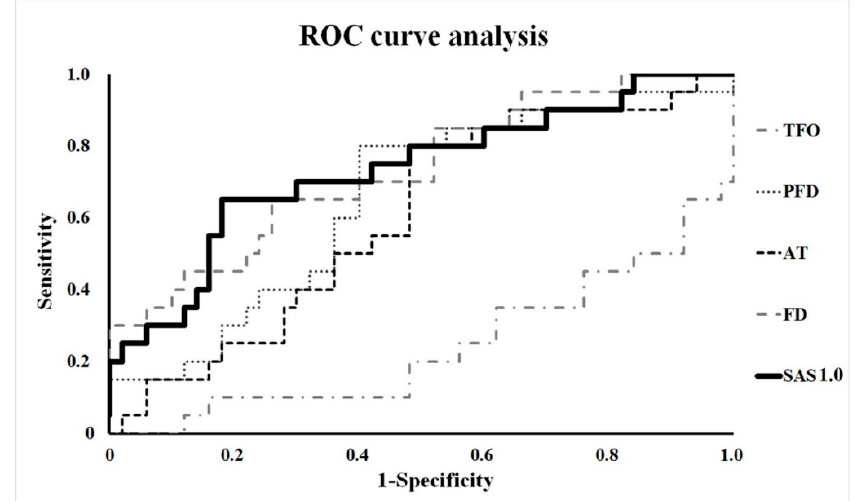
Figure 3. Receiver-operating characteristic (ROC) curve analysis. The result showed that the ratio of SAS 1.0 was the most reasonable, having the highest sensitivity and specificity among the other parameters of radiograph and CT (95% CI = 0.598–0.869).